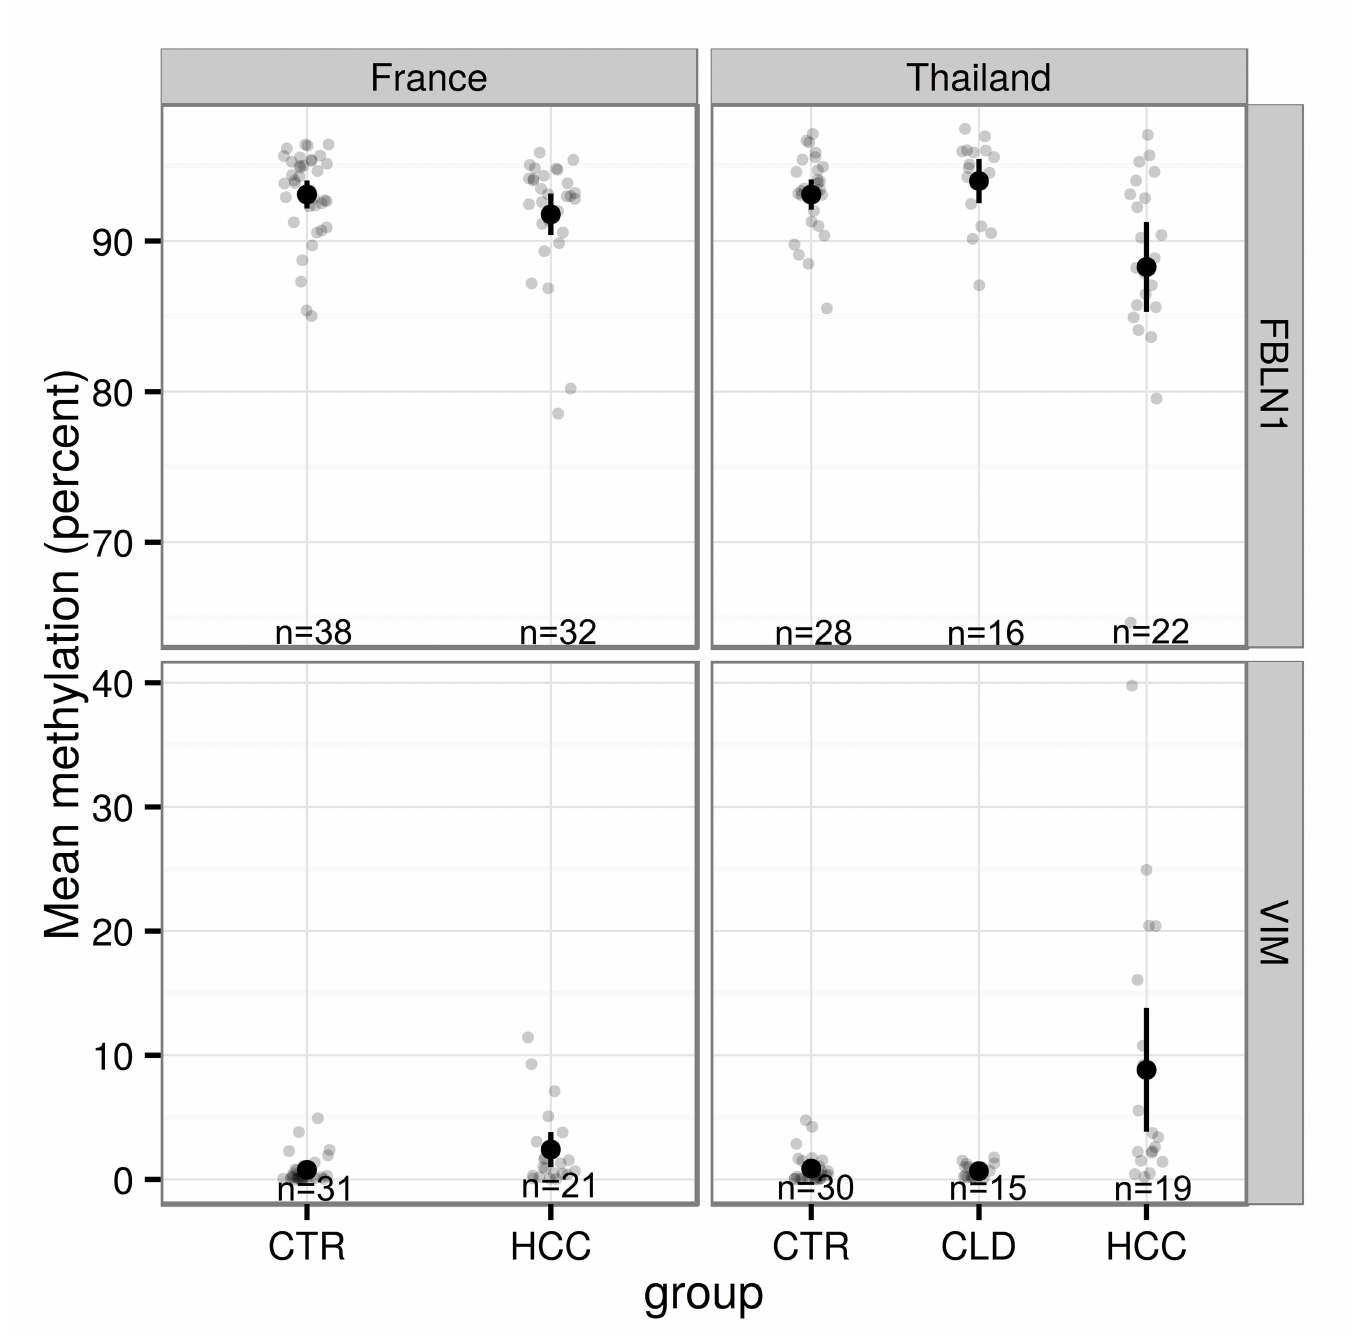
Fig 1. Mean methylation proportions and 95% confidence intervals for FBLN1 and VIM in France and in Thailand. HCC = hepatocellular carcinoma, CTR = control, CLD = chronic liver disease. exception of HepG2 and HepG2/2.2.15 that had lower mean methylation levels (10.1% and 56.2% respectively), whereas for VIM the methylation pattern seemed to vary with TP53 muta- tion status. For the cell lines with wild type TP53 (HepaRG, HepG2 and HepG2/2.2.15), the